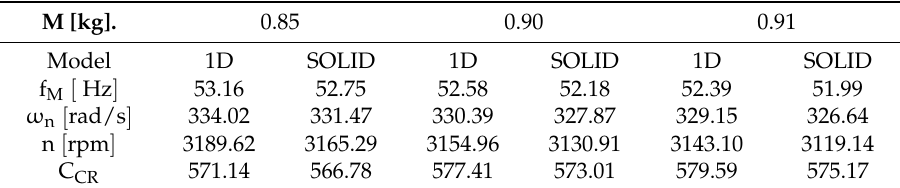
Table 9. Mass and eccentricity values for each rotor